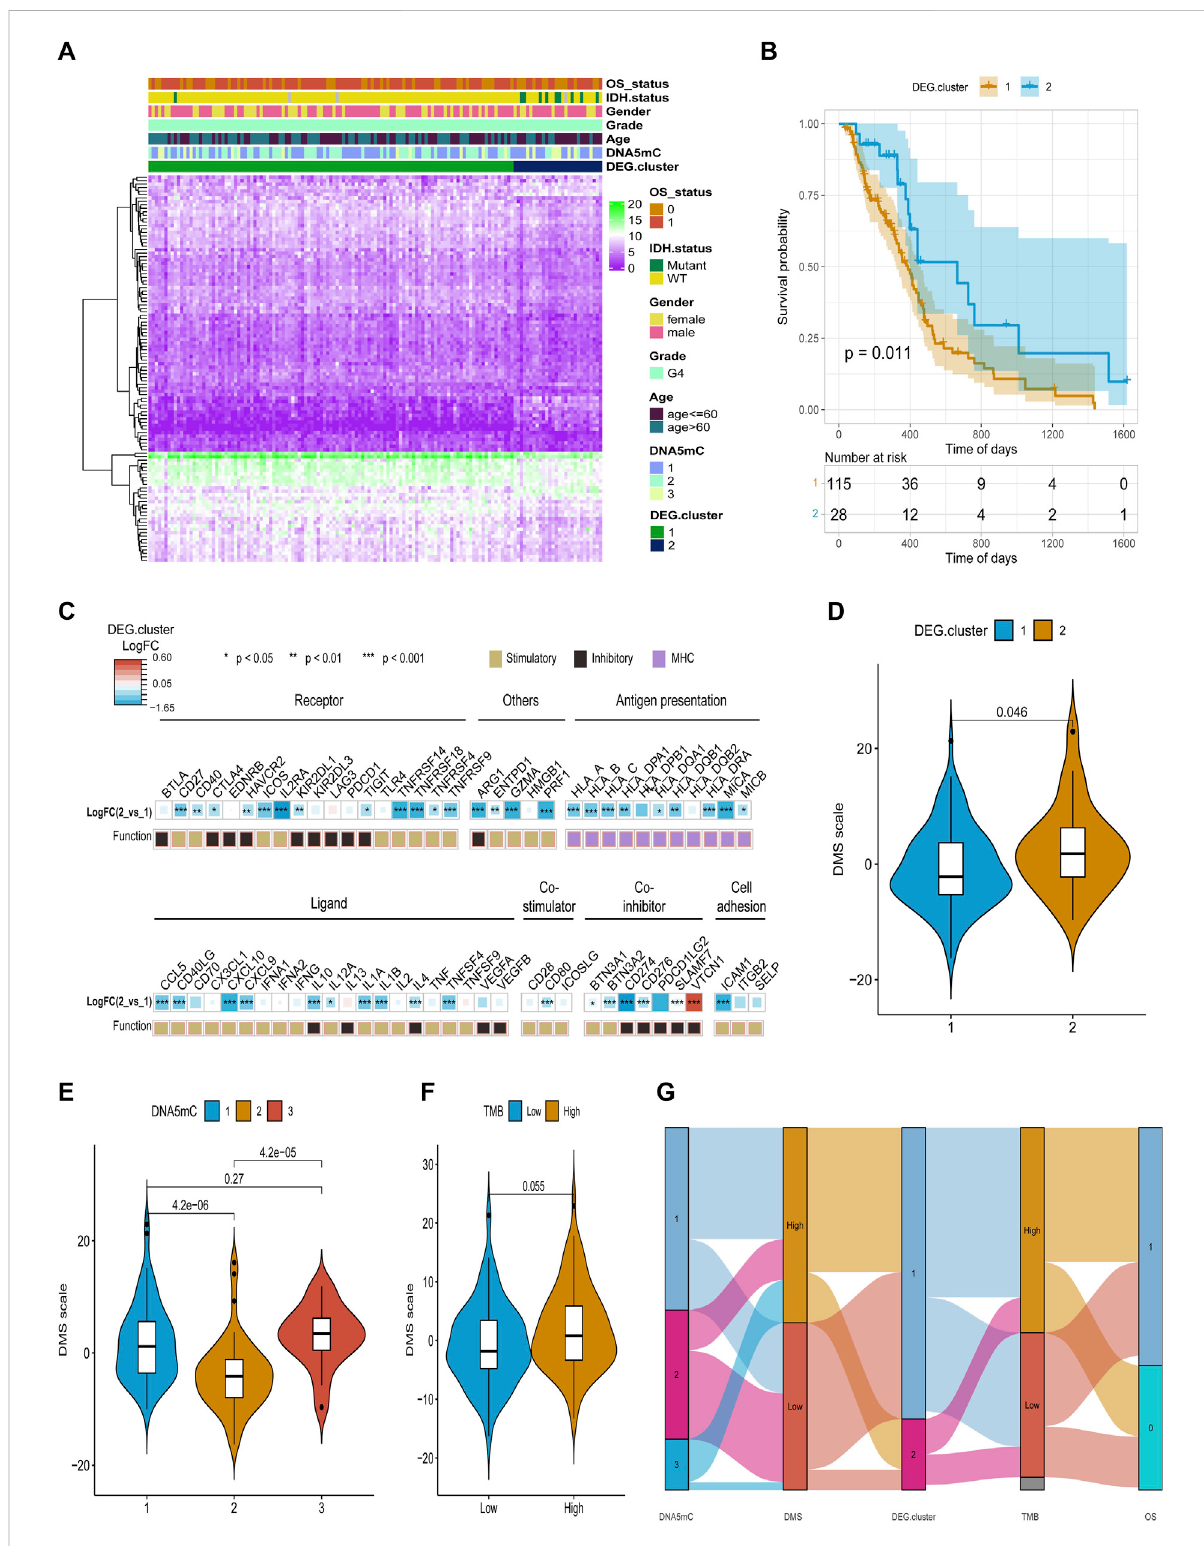
FIGURE 7 Identi fi cationandcharacterizationofDEG.cluster-1and-2subtypes. (A) Anoverviewofdifferentialgeneexpressionpro fi les. (B) Survivalcurves for distinct DEG. cluster groups. (C) A comparison of immune signaling factors among DEG. cluster subgroups. (D – F) Different DNA DMS for TMB groups, DNA5mC subtypes, and DEG. cluster subtypes. (G) Dynamic fl ow diagram of each GBM sample grouping and state